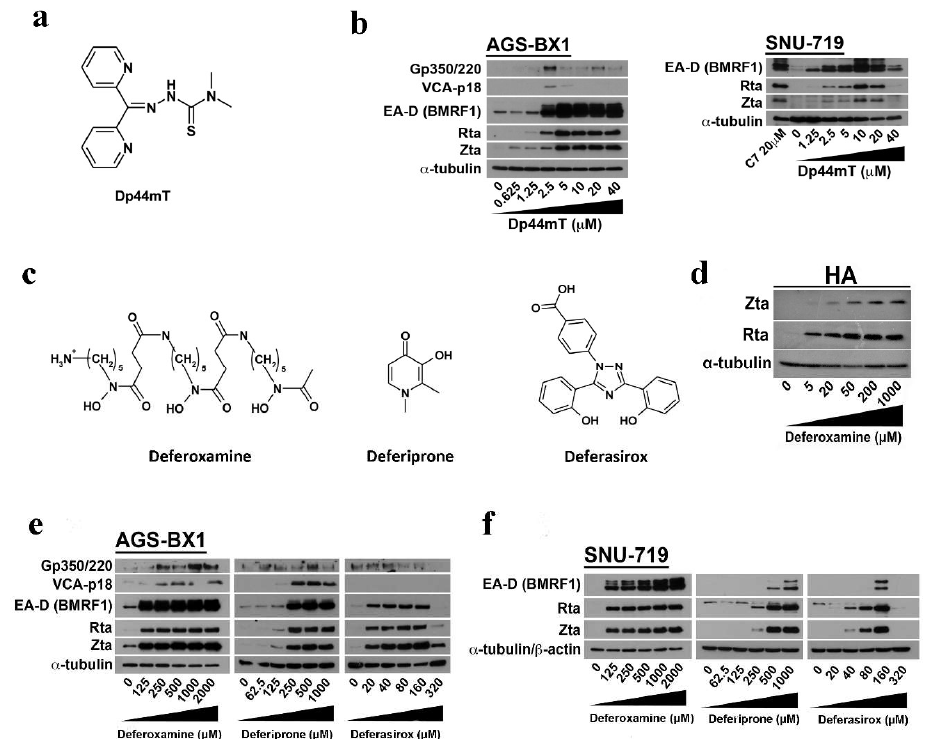
Figure 2. EBV lytic reactivation by clinical iron chelators which are structurally distinct from C7. ( a